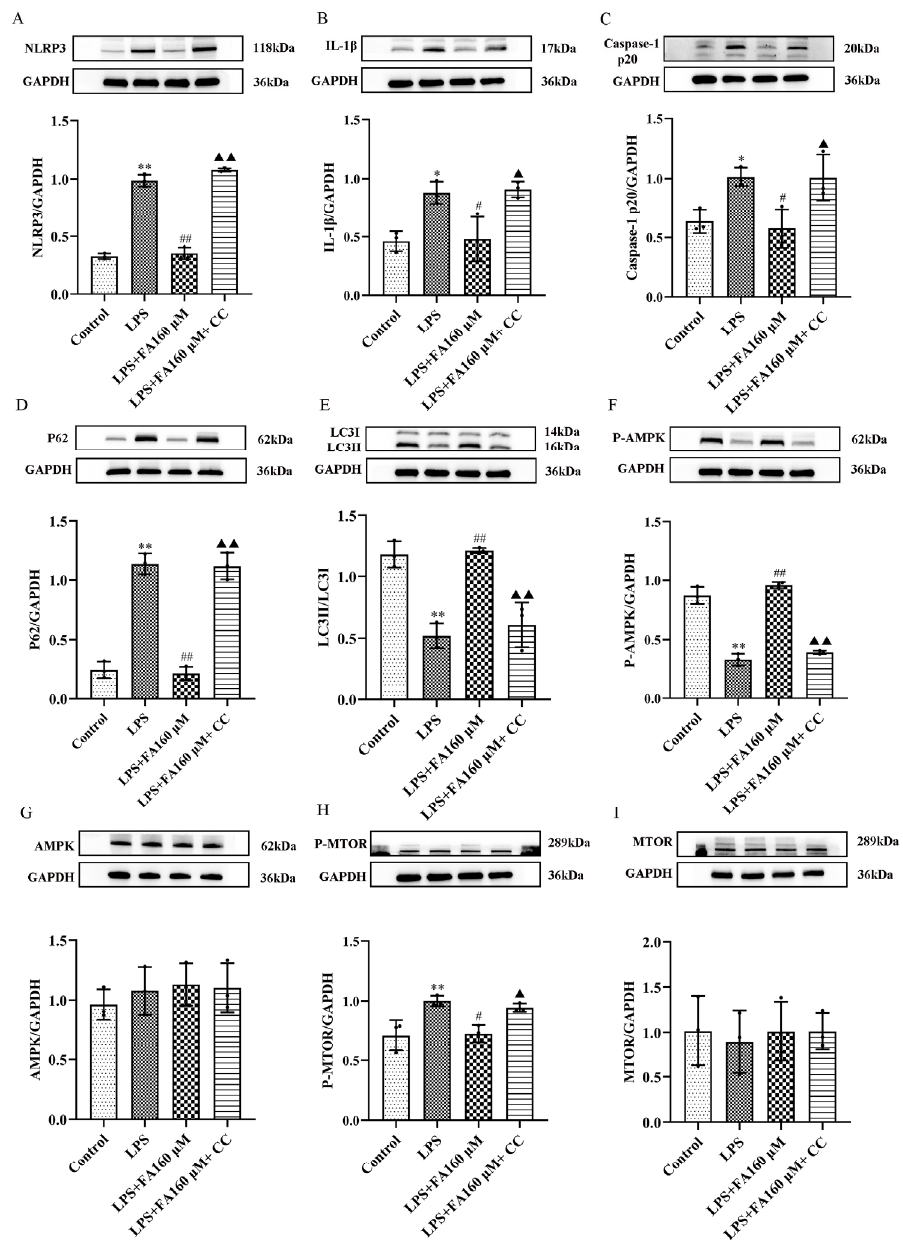
Figure 7. AMPK inhibitors destroy all bene fi cial e ff ects of FA. ( A – I ) NLRP3, IL-1 β and caspase-1 p20 were detected via Western blot. Autophagy-related proteins LC3 and P62 and pathway proteins P-AMPK/GAPDH, AMPK/GAPDH, P-MTOR/GAPDH and mTOR/GAPDH were expressed. Data are means ± standard deviations (SDs) ( n = 3). ** p < 0.01, * p < 0.05, vs. control; ## p < 0.01, # p < 0.05, vs. LPS; ▲▲ p < 0.01, ▲ p < 0.05 vs. FA + LPS.